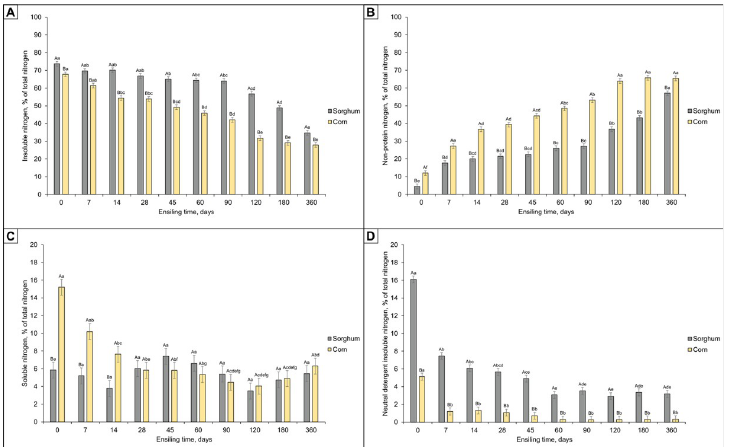
Fig 1. Effect of grain source and ensiling time on insoluble N (A), non-protein nitrogen (B), soluble N (C), and neutral detergent insoluble nitrogen (D) of reconstituted and ensiled grains. Grain source P -value, < 0.01; Ensiling time P -value, < 0.01; Interaction grain source and ensiling time P -value, < 0.01. A,B Upper case letters compare grains within ensiling time. a-g Lower case letters compare ensiling times within grain source. Means with different superscripts differ significantly at P �